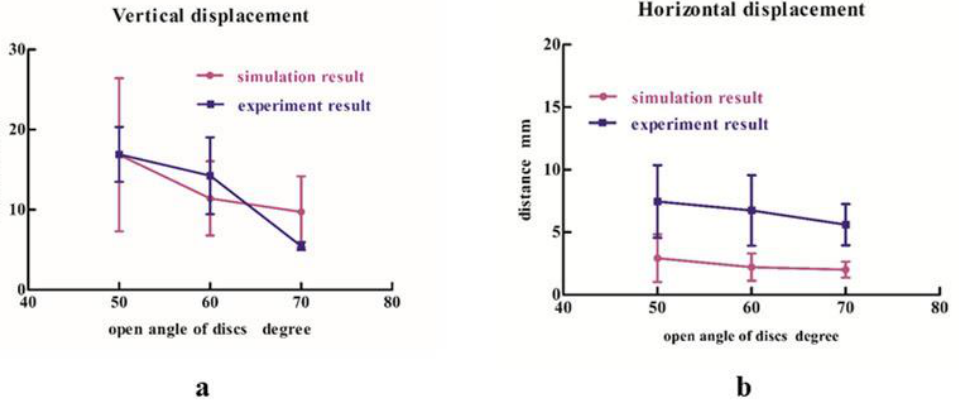
Figure 15. Comparisons of displacements of seeds after soil covering for the variety of open angles of the soil covering discs between simulations and experiments.